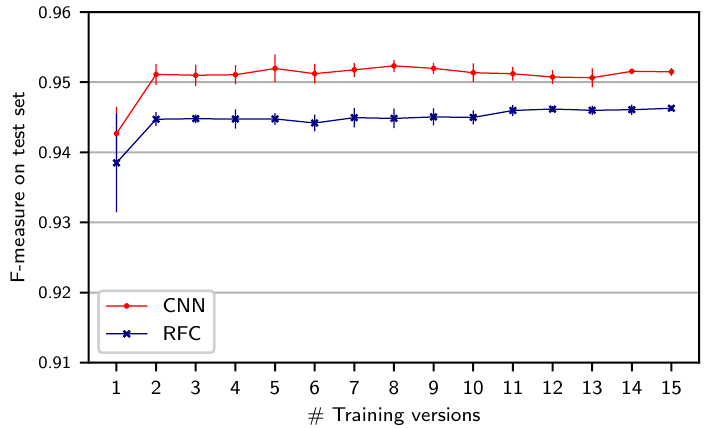
Figure 4. Results for both systems when training on varying numbers of versions of the test act ( version split ).